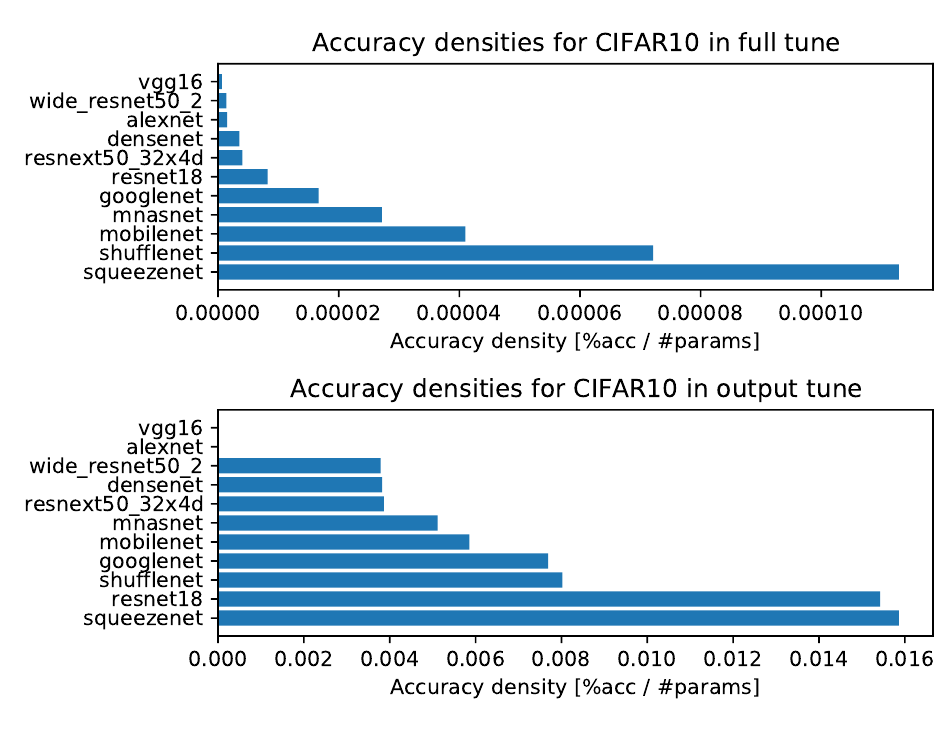
Figure A1. Accuracy densities for one-episode learning on CIFAR-10.